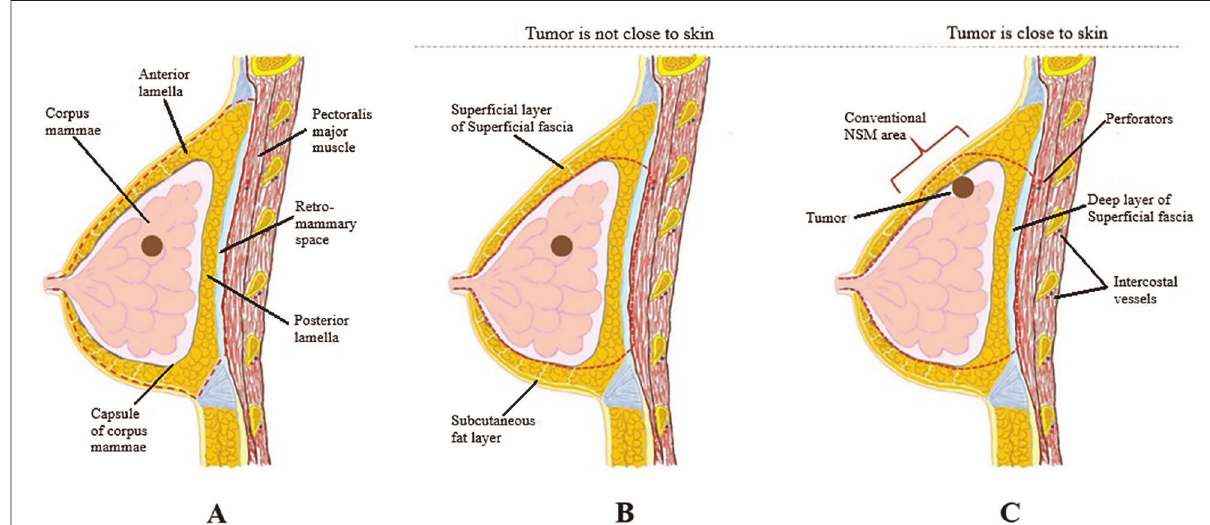
FIGURE 1 ( A ) Dissection plane in c-NSM: a dissection plane is on the super fi cial fascial plane, and the plane between pectoralis major fascia and muscle is a posterior plane of dissection; ( B ) dissection plane in m-NSM when the tumor is not close to breast capsule: anterior dissection plane is on breast capsule and posterior dissection plane is between pectoralis major fascia and muscle; ( C ) dissection plane in m-NSM when the tumor is in contact with the capsule of corpus mammae: anterior dissection plane is on super fi cial margin near the tumor which is same with c-NSM. c-NSM, conventional nipple-sparing mastectomy; m-NSM, modi fi ed nipple-sparing